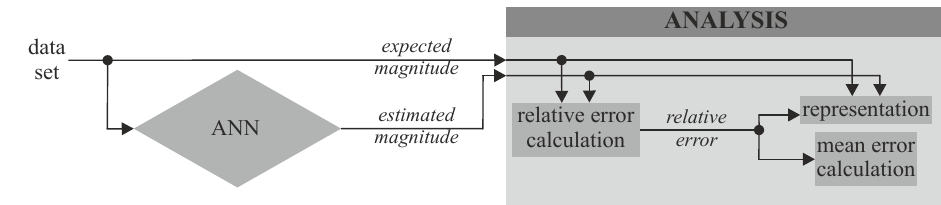
Figure 3. Diagram of the validation